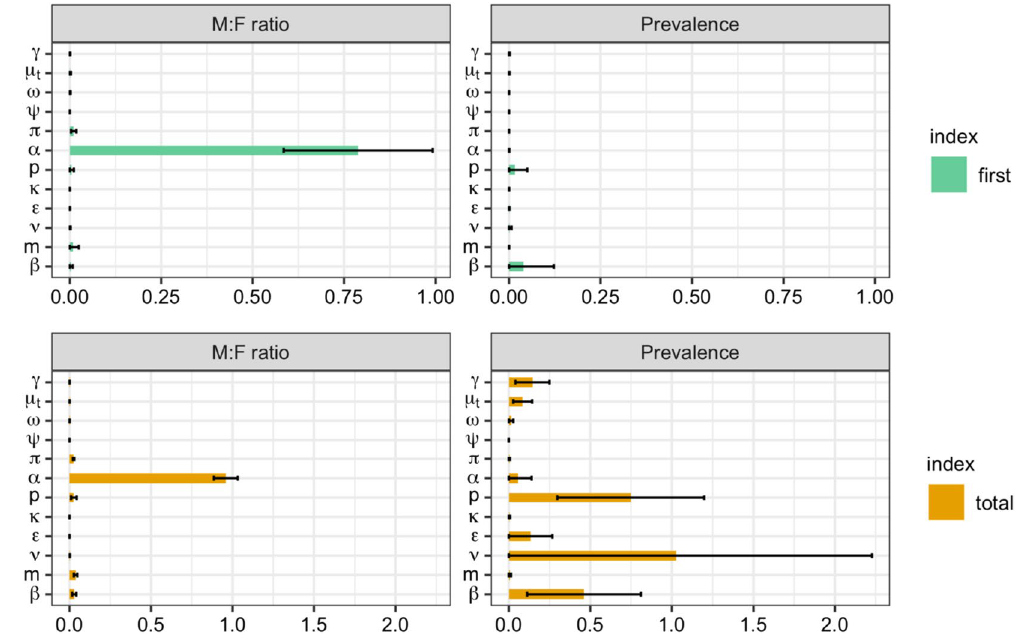
Figure 3. Sobol’ first-order (one-way) and total sensitivity indices (including interactions) for equilibrium prevalence M:F ratio and total TB prevalence (shown on x-axes). Distributions of parameters (y-axis) are as in Table 1 ( ψ —partial protection, ν —reactivation, ǫ —fast progression, κ —stabilization, ω —relapse, γ —self-cure, µ t —TB mortality, p —detection, β —effective contact, ρ = 2 m − 1 —assortativity, π —differential detection, α —differential